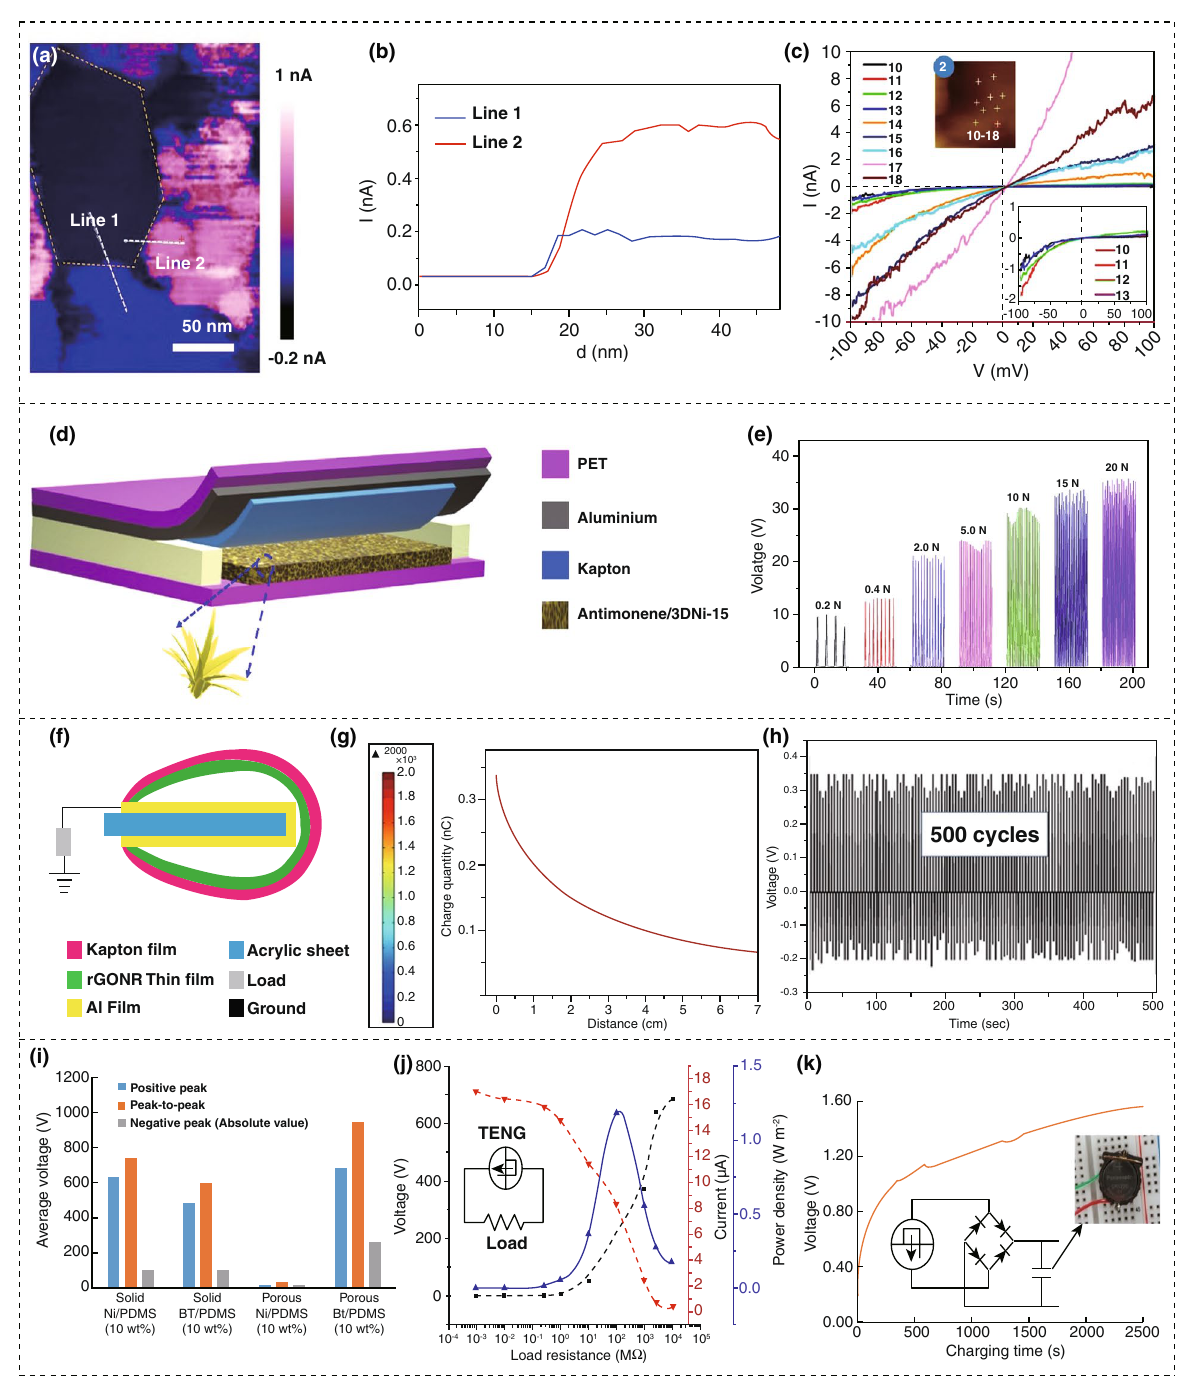
Fig. 5 Schematics of structure and output performances of triboelectric nanogenerators. a Image of the adjacent MoS 2 crystal divided into three grains from atomic force microscope and their current distribution in the three regions. b Cross-sectional current lines in the grains. c Spectrum of current–voltage characteristics of the grains 2. d Schematic of the triboelectric nanogenerator. e Rectified output voltage from the device. f Schematic of triboelectric nanogenerator with a single electrode based on reduced graphene oxide nanoribbons/ polyvinylidene fluoride. g Gen- erated charges of Al foil, which decreases with the increasing gap between the film and foil. h Stable operation of triboelectric nanogenerator for 500 cycles. i Comparison of triboelectric generator voltage while fabricated by porous and solid nanocomposites. j Output voltage, current, and power. k Performance in powering a lithium coin cell. Figures reprinted with permission from: a , b , c Ref. [84], © 2018 Nature; d , e Ref. [85], © 2020, Elsevier; g , h , i Ref. [71], © 2016 Nature; j , k , l Ref. [72], © 2018